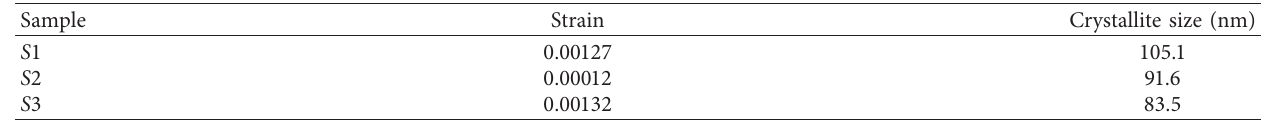
Table 3: Crystallite size and strain of S 1, S 2, and S 3.